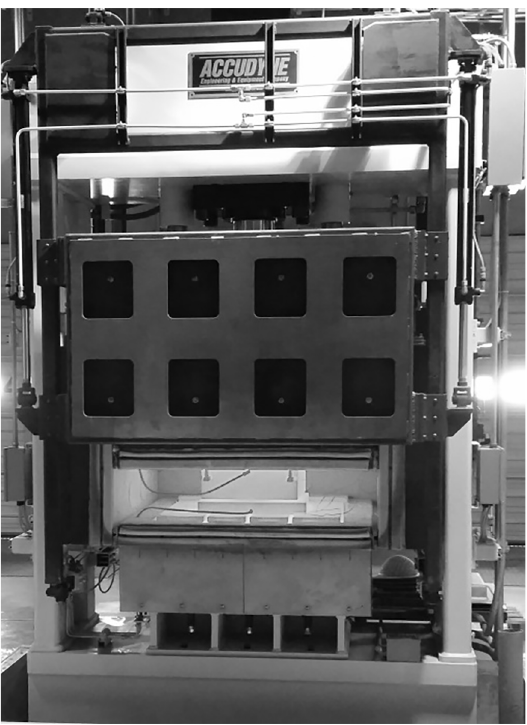
Figure 1. Superplastic forming Accudyne machine used in the